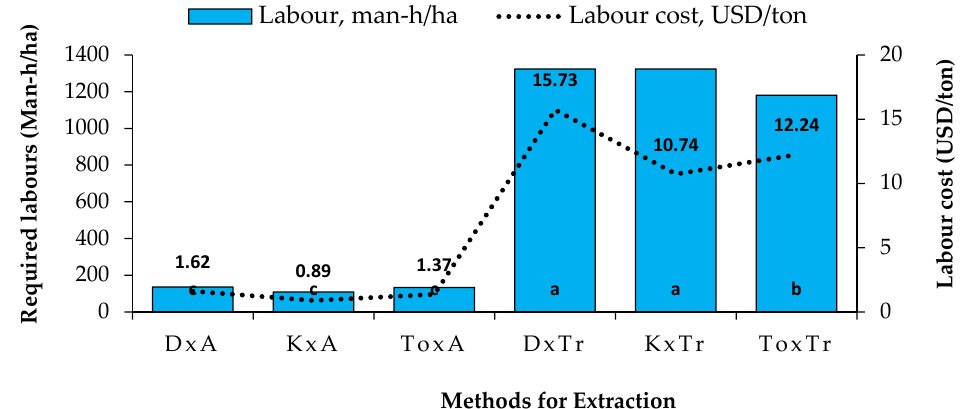
Figure 16. Interaction effect of extraction methods and jute type on labor requirement and labor cost. The highest price of jute fiber was 537.96 USD t − 1 , which was found in the improved Aashkol-based processing method. The jute fiber price significantly varied with jute variety. The highest jute fiber price was found in the kenaf variety. Fiber prices of deshi and tossa jute were statistically similar. The highest price of jute stick was found when using the traditional methods. The jute sticks were broken by the Aashkol, which reduced the price. Although the price of whole jute stick produced with the traditional method was higher, it required more time and some extra investment for drying and handling. Jute stick price also varied with jute variety. The highest price of jute stick was found in deshi (16.68 USD t − 1 ) and tossa jute (16.39 USD t − 1 ). The lowest price of jute stick was found in kenaf